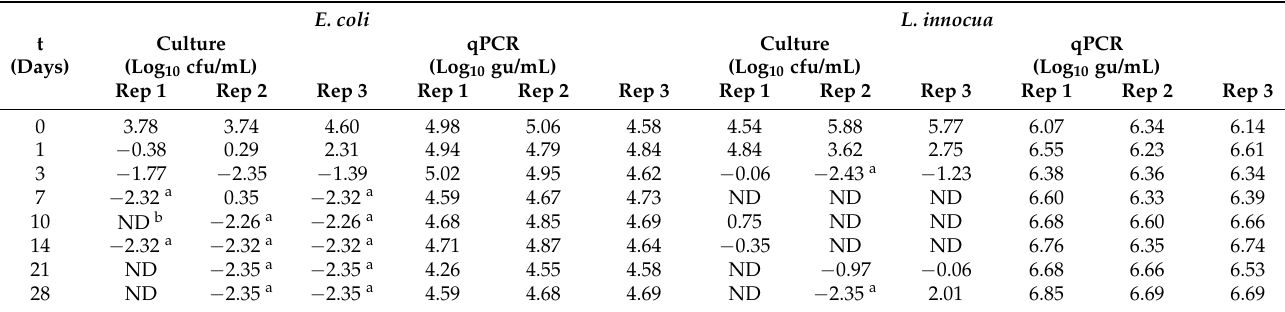
a The presented culture results correspond to direct sample plating or sample enrichment. For enriched samples, the value of 0.5 cfu/mL of concentrated sample was assumed, with the limit of quantification calculated based on the volume of the pellet after sample concentration. b ND = not